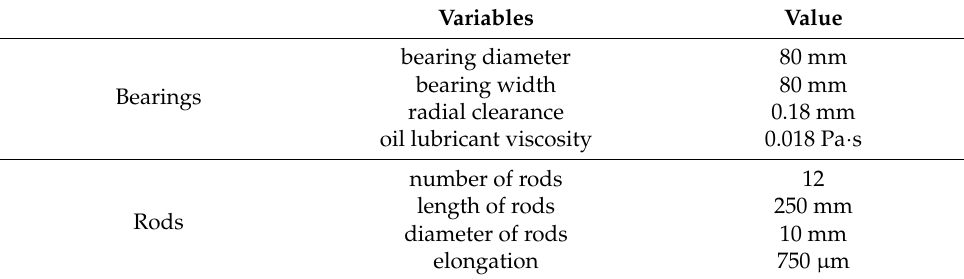
Table 1. Parameters of bearings and rods.